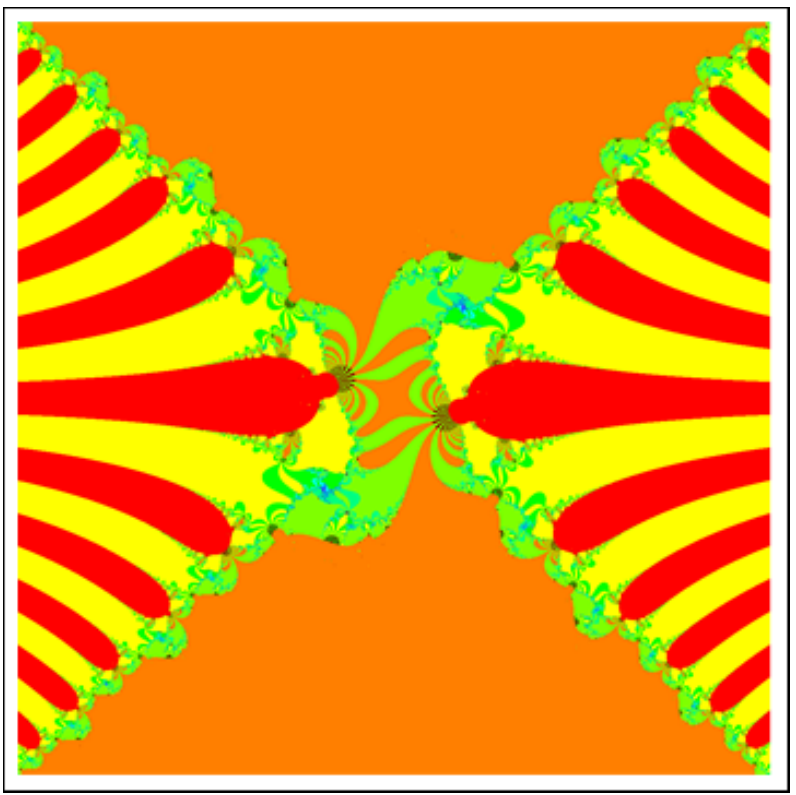
Figure 10. J-set for τ ( z ) = e z 2 + c via DKIS. The image execution time is 137.187 s.